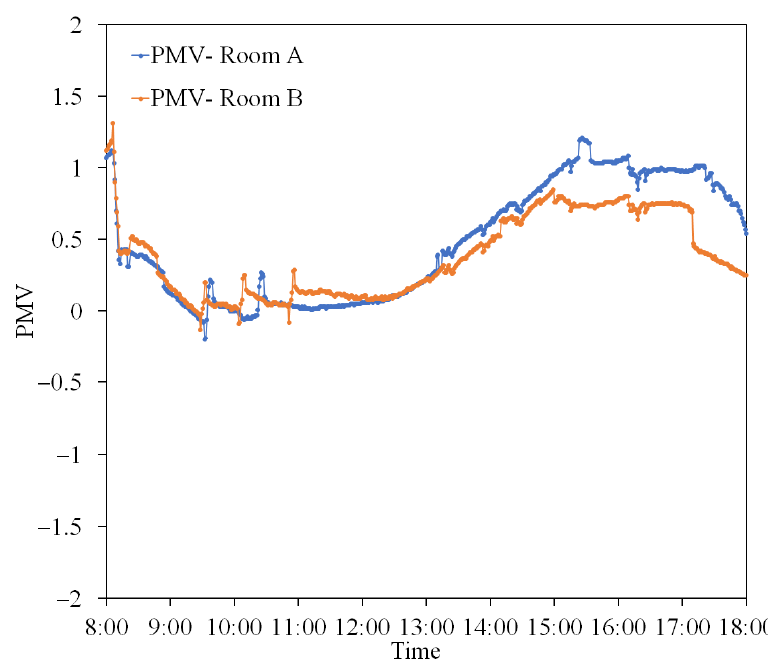
Figure 11. PMV value on May 26th.